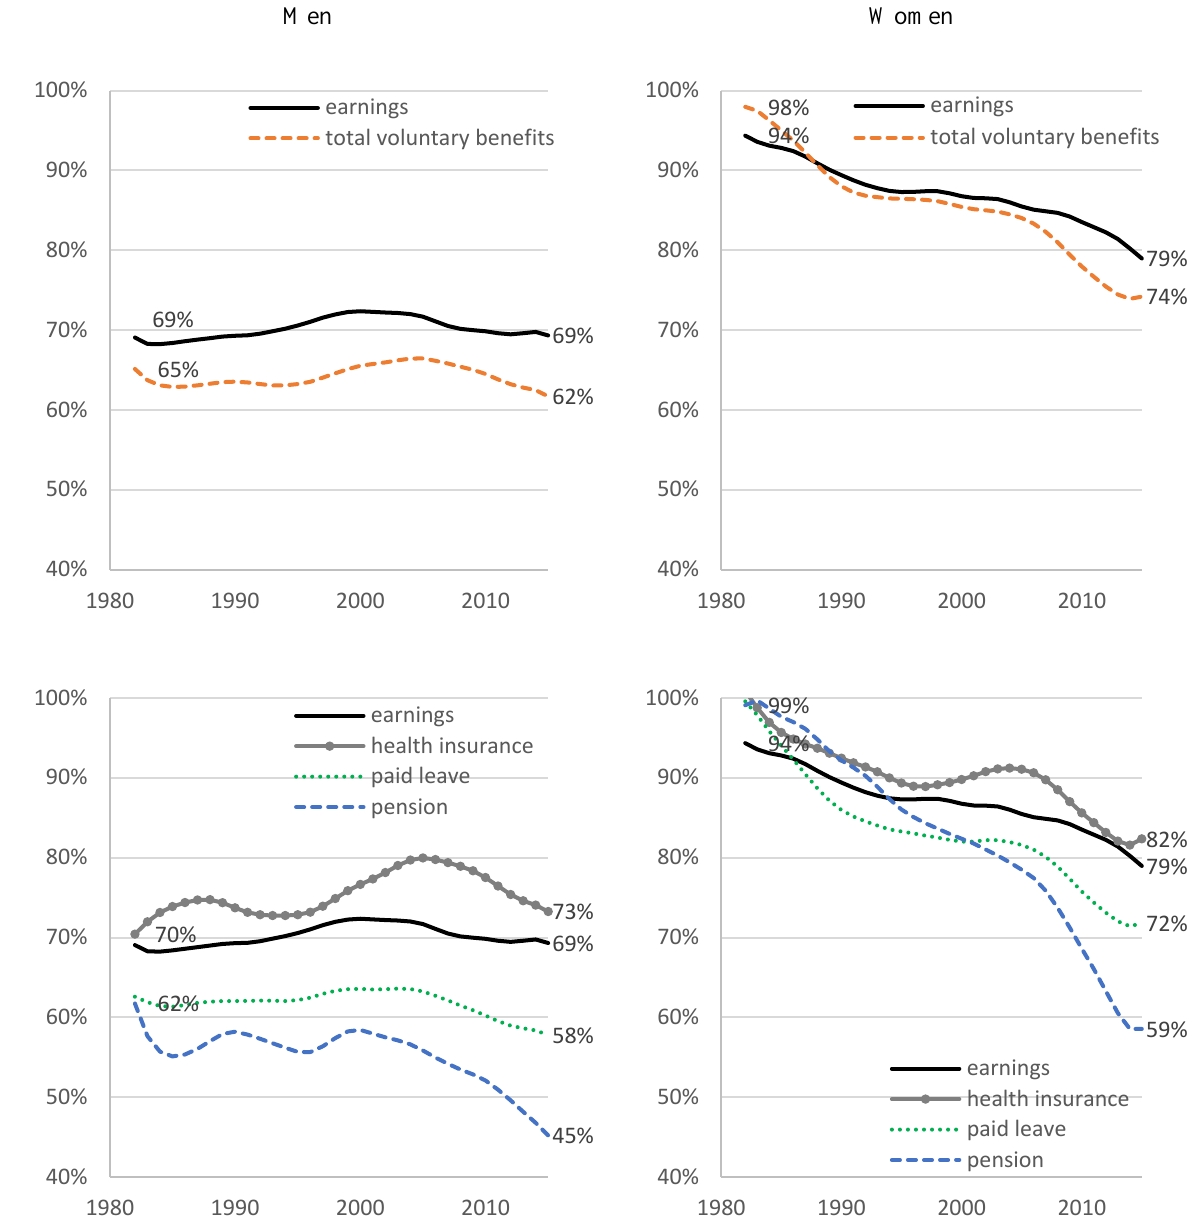
Figure 5: Black-to-white health insurance, pension, paid leave, and total voluntary benefits and earnings ratios (percentages), 1982–2015. Notes: Weekly wages and weekly employer-provided benefit costs